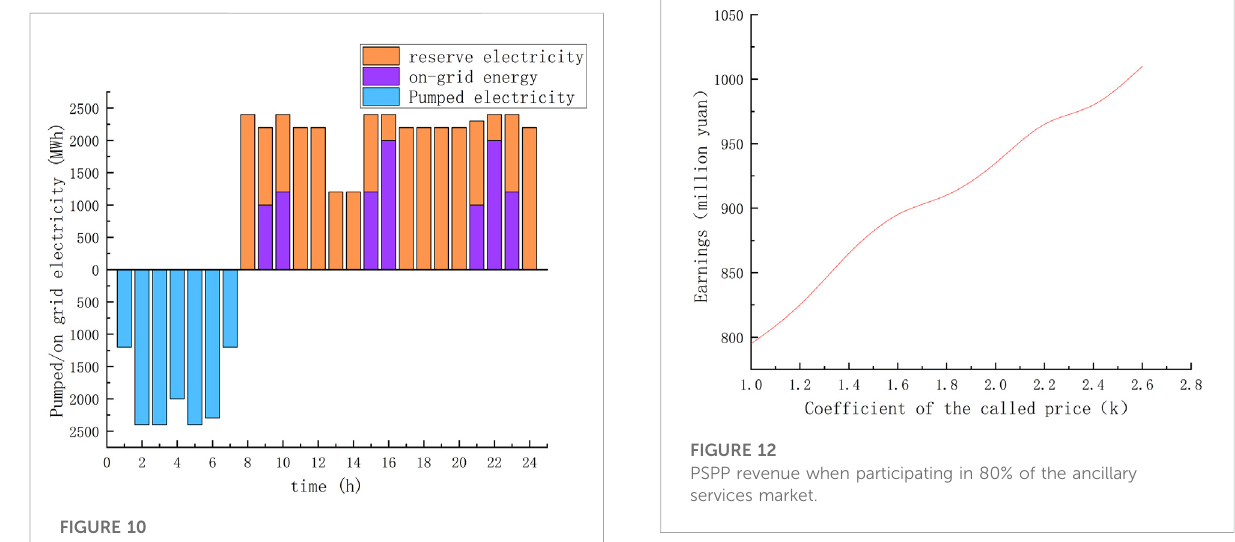
FIGURE 10 Operation of PSPP ( β (cid:1) 10).